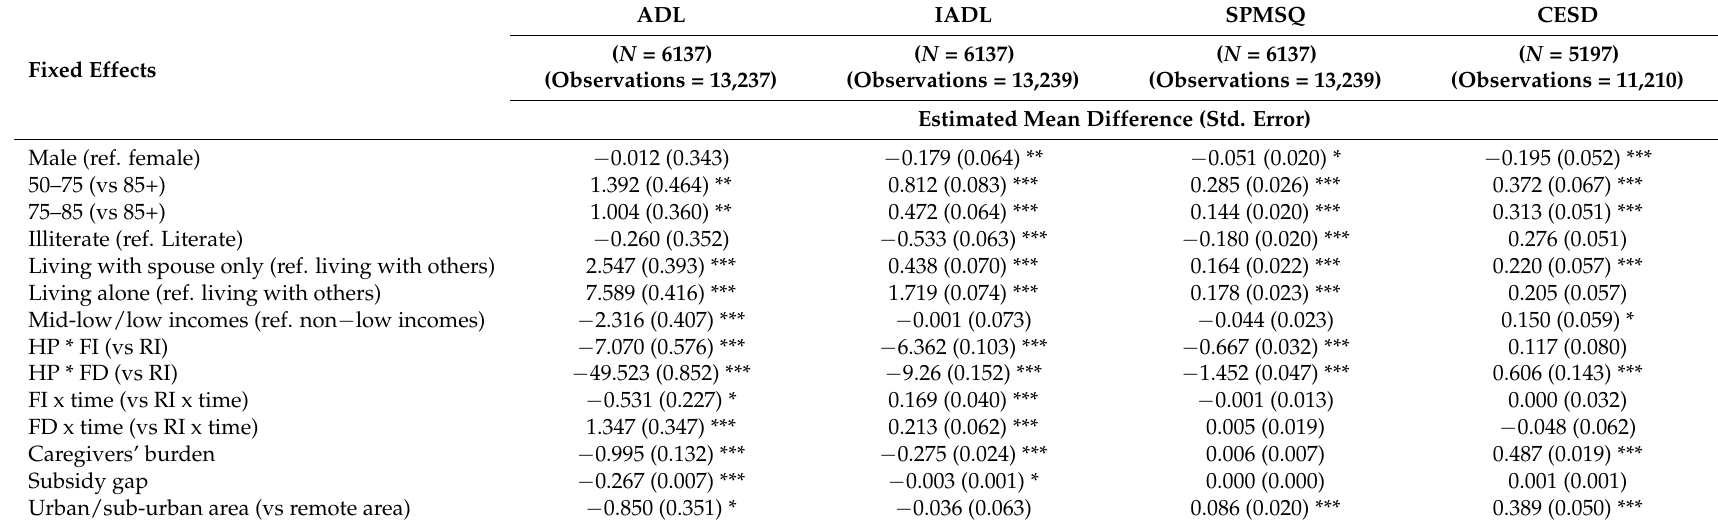
Table 4. Predictors of the two-year outcomes among the long-term care recipients in HCBS (Mixed effect